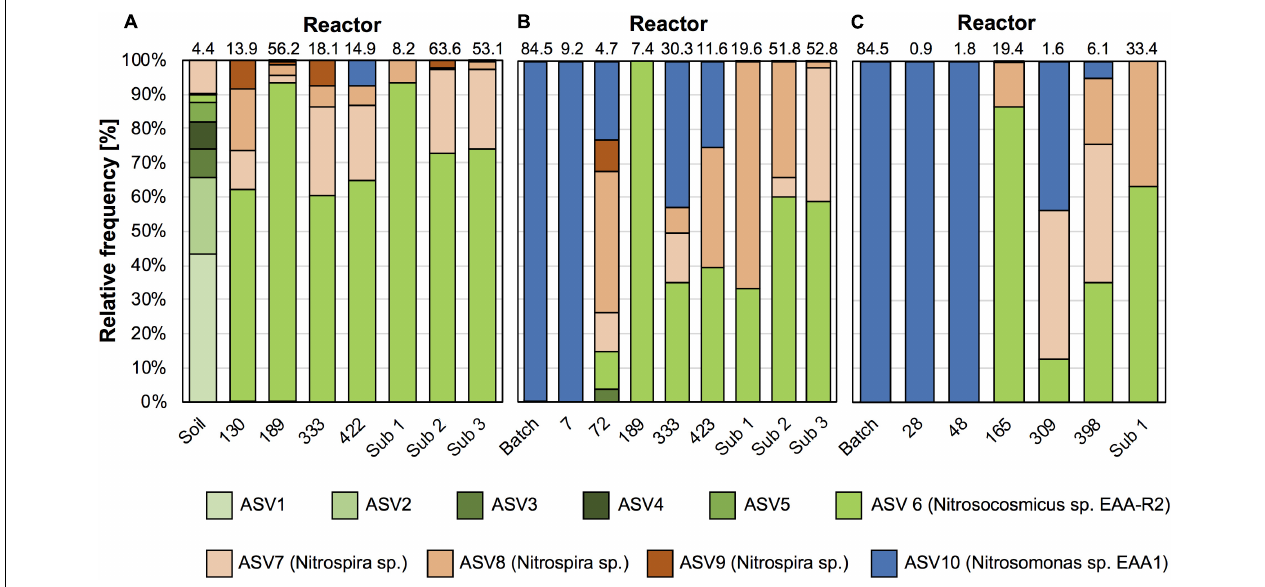
FIGURE 2 | Time series of nitrifier community composition in reactors A , B , and C . Given are relative frequency of 16S rRNA genes affiliated with thaumarchaeal AOA (green), betaproteobacterial AOB (blue), and Nitrospira sp. (beige) of all nitrifier-associated sequences. Numbers on top indicate relative abundance of nitrifiers in each whole community sample in%. Sub 1, Sub 2, and Sub 3 refer to sub-culture reactors 1, 2 and 3, respectively.